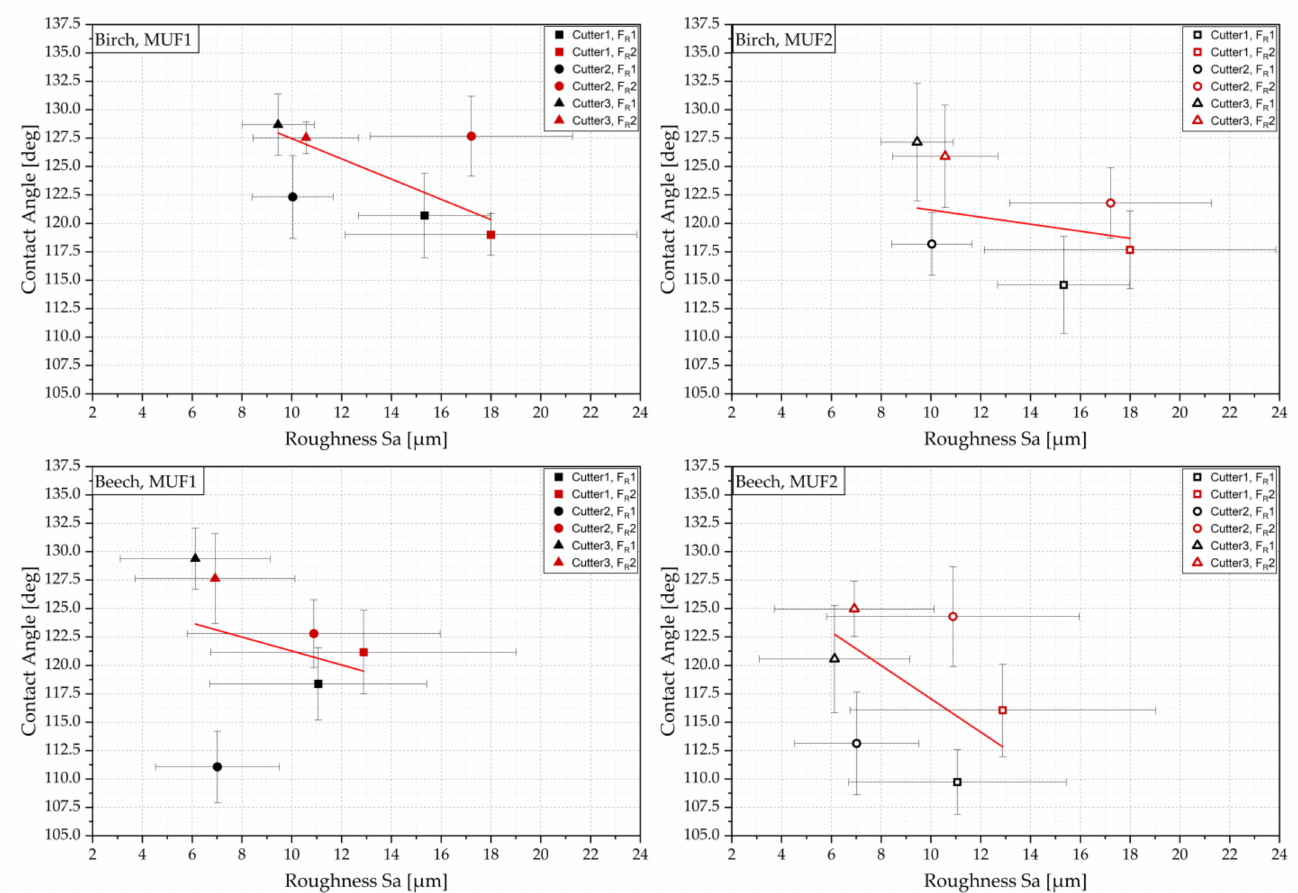
Figure 14. Interactions between contact angle and roughness for different cutting combinations; red line shows trendline and error bars show standard deviation in x (roughness) and y (contact angle) direction.